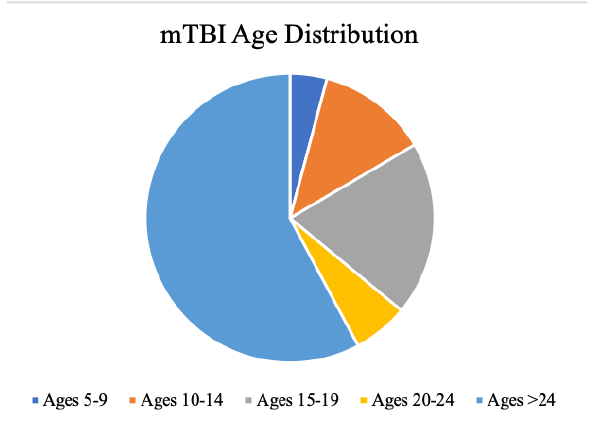
Figure 2. Distribution of mTBI incidence. Ages 5-24, less than two decades, account for 42% of the entire mTBI population, with ages 15-19 most dominant. Data adapted from (Zhang et al.,